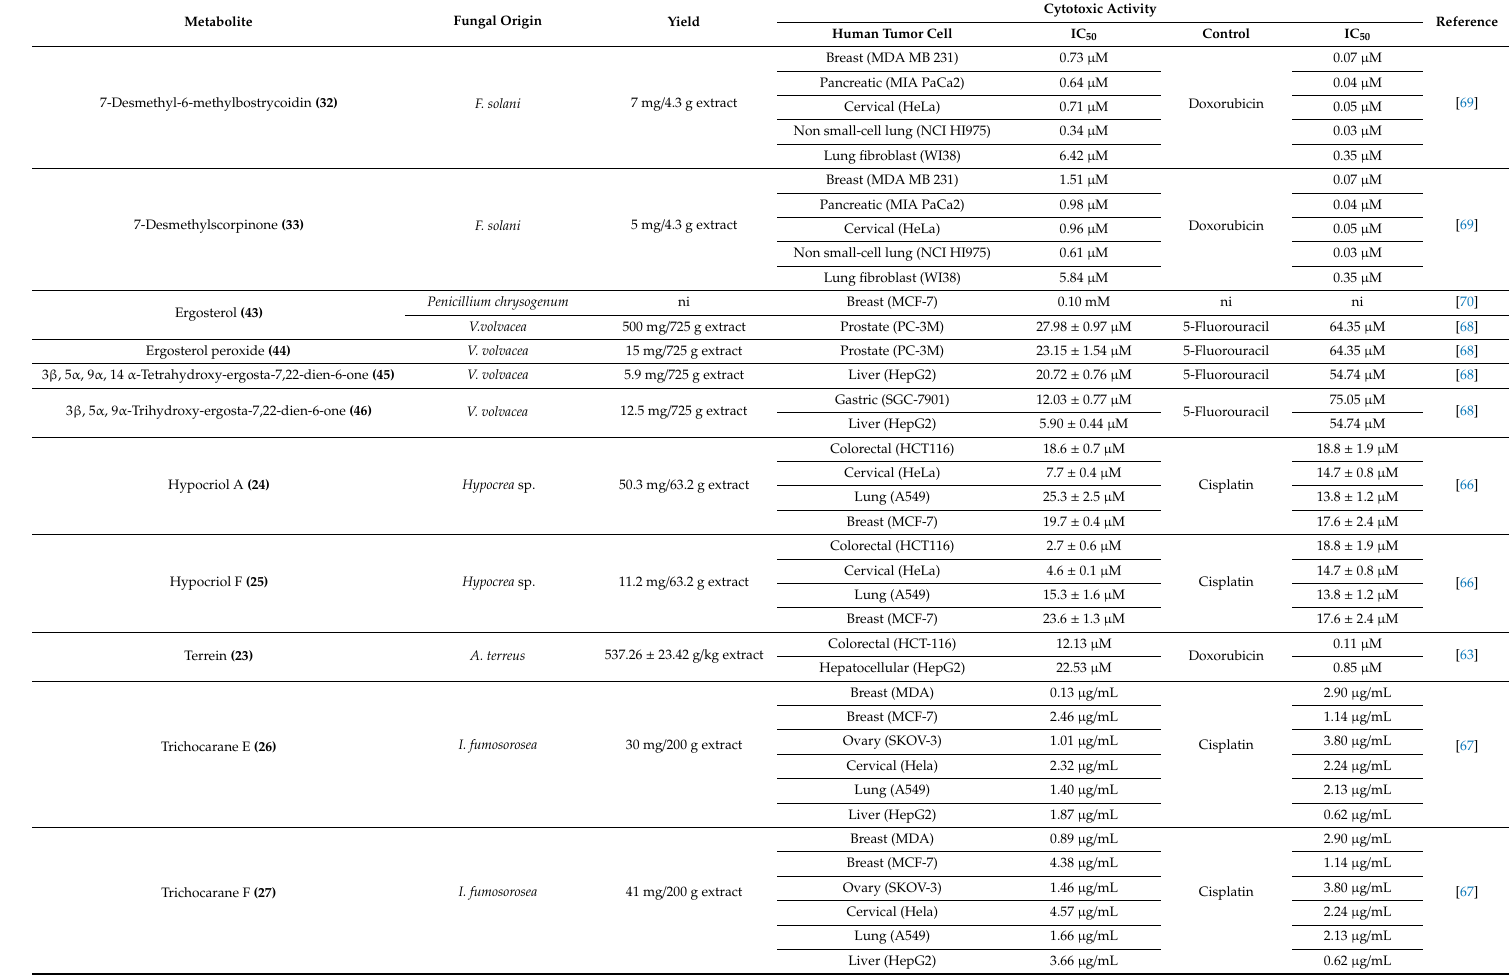
Table 3. Cytotoxic activity of some fungal secondary metabolites against several human tumor cell